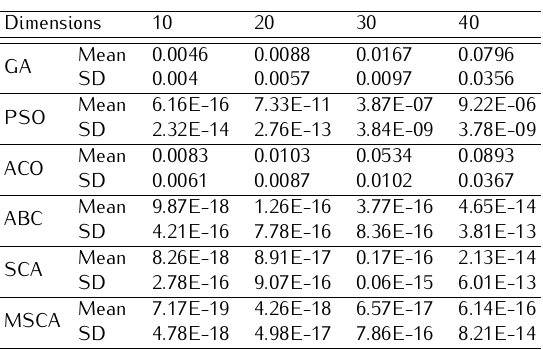
Table A.1. The results of GA, PSO, ACO, ABC, SCA and MSCA for Sphere function.